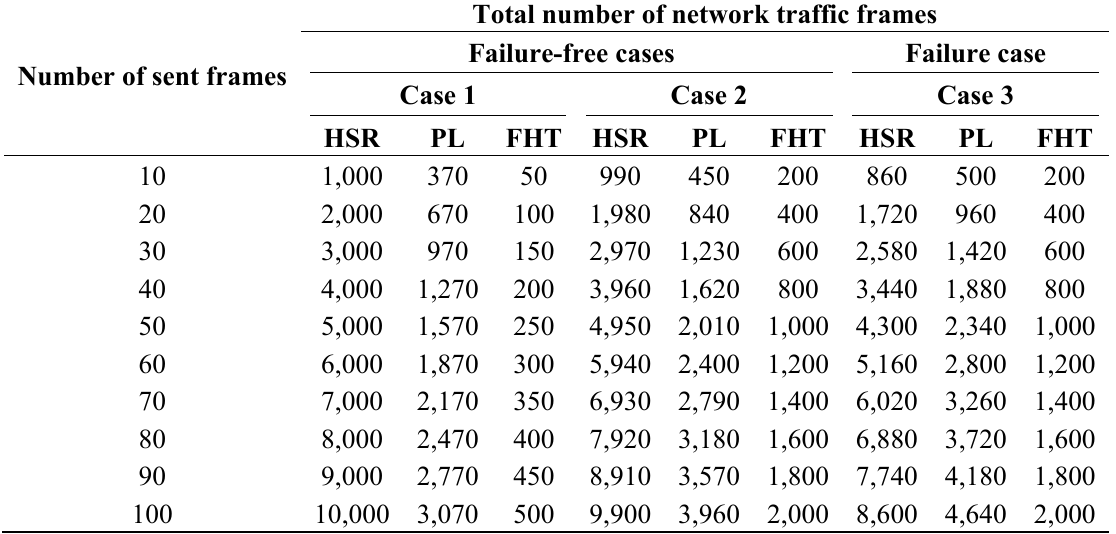
Table 2. Network traffic frames in three simulated